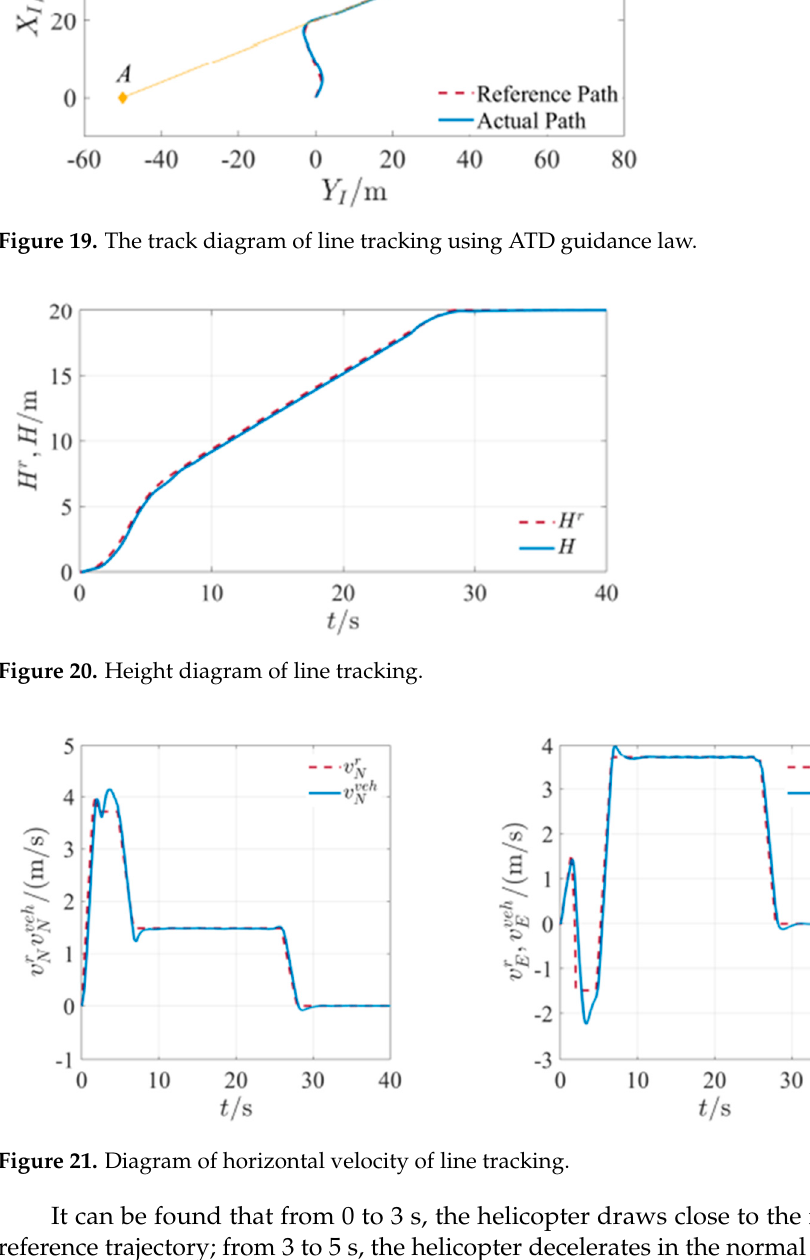
Figure 21. Diagram of horizontal velocity of line tracking.